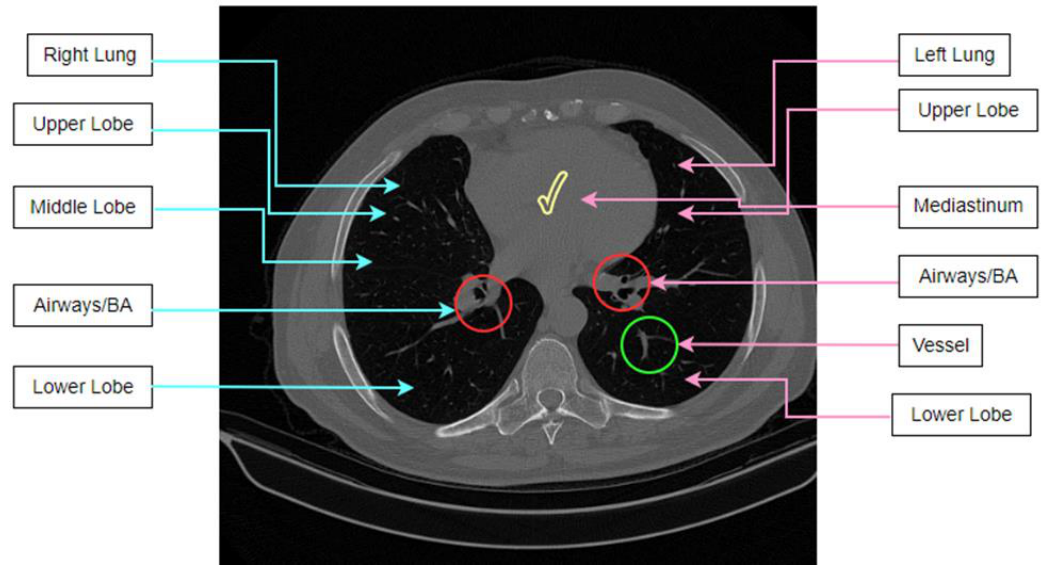
Figure 2. Anatomical structures in a lung CT scan.